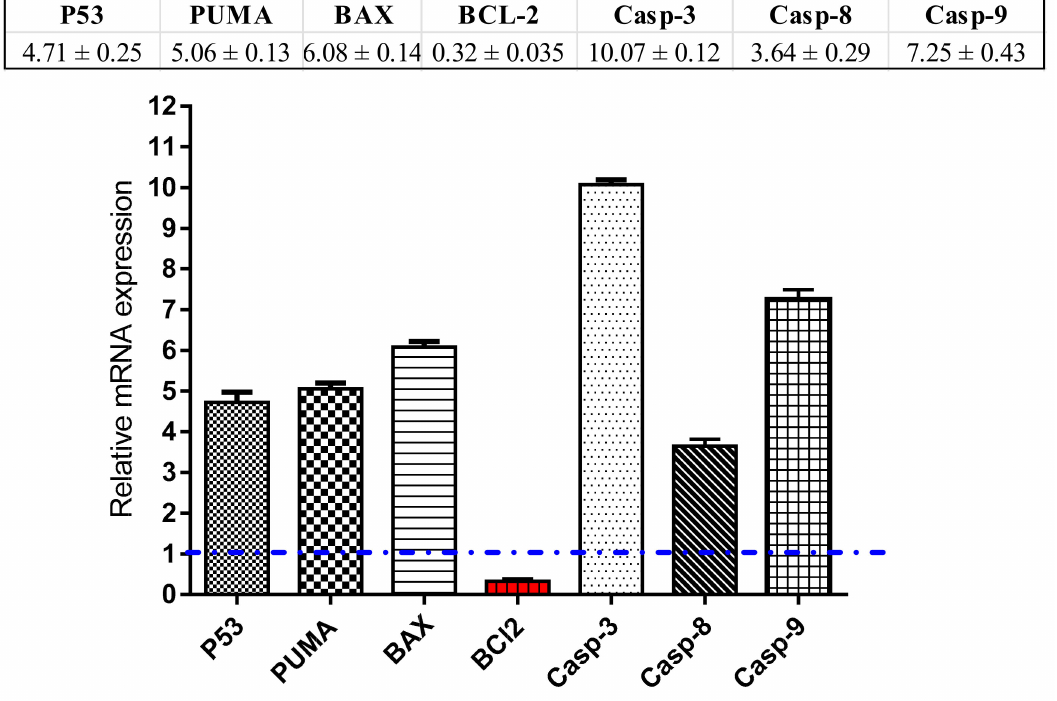
Figure 8. RT-PCR analysis of the apoptosis-related genes was performed after the MCF-7 cells were treated with phenolics extract (13.04 µ g / mL) for 72